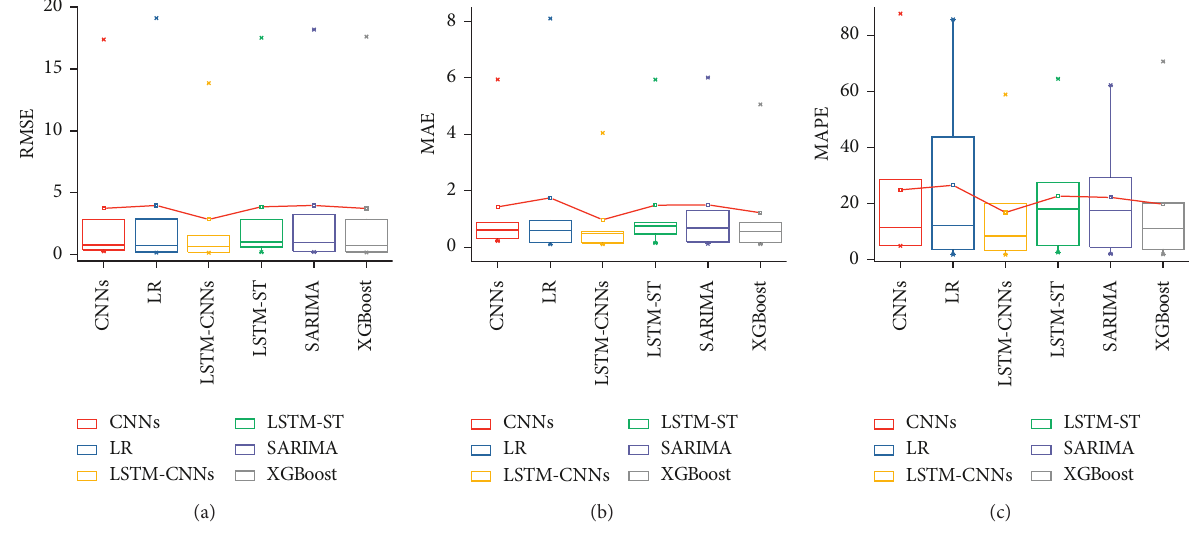
Figure 13: Error results of different methods. Table 7: Error results of different methods.